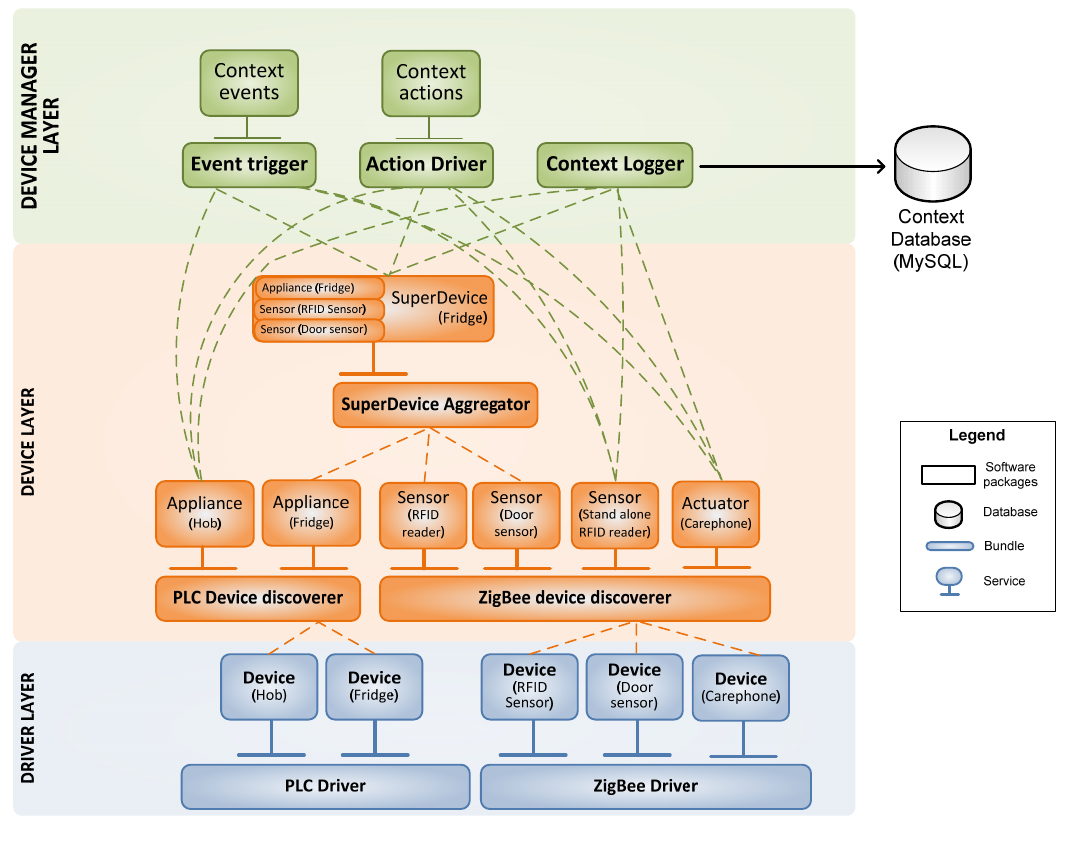
Figure 4. Architecture detail of the Context